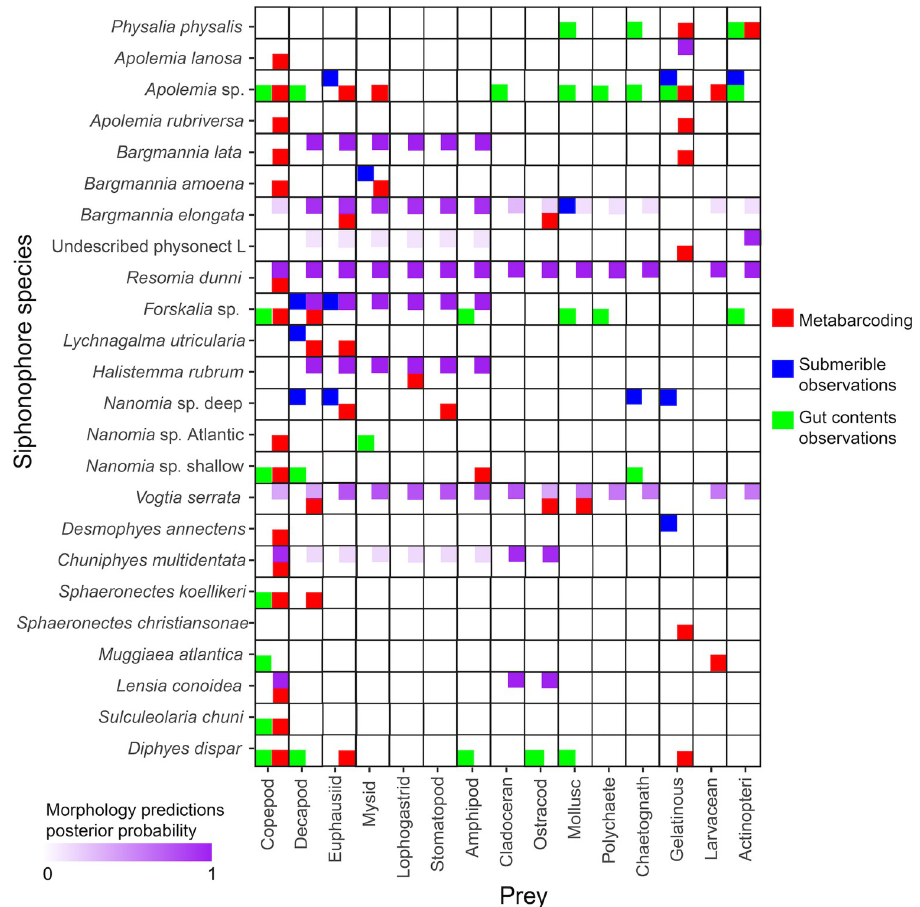
Fig 5. Feeding interactions between siphonophores and their prey from different data sources. Including prey identified by our metabarcoding results (red), observations published submersible observations (blue), observations published visual gut content analyses (green), and prey types predicted by the morphology-based DAPC model in Damian-Serrano et al. [27]. Gelatinous prey refers to ctenophores, medusae, and salps. Larvaceans were excluded as their own category since they are not gelatinous when swimming freely outside their mucous ‘houses’, which would be the only times they would be able to trigger a prey-capture response in siphonophore tentacles.